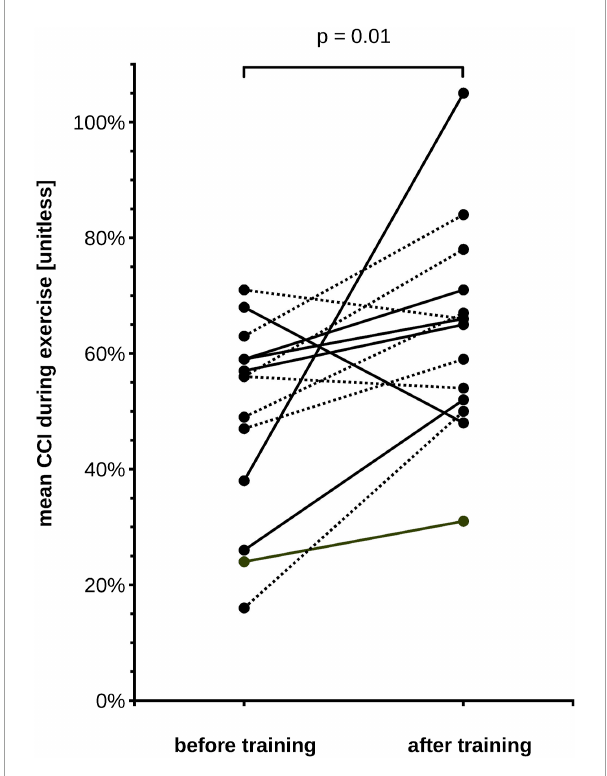
FIGURE 4 Central conduction index (CCI) during exercise for each of our 15 subjects, before and after training. CCI is averaged across the individual measurements during the 2 nd minute of exercise (75–120 s). Note that the mean exercise-CCI increased in 12 subjects and decreased slightly in 3 subjects. The group means differ significantly (Wilcoxon signed rank test, p -value in the figure). Solid lines depict male subjects, dotted lines female